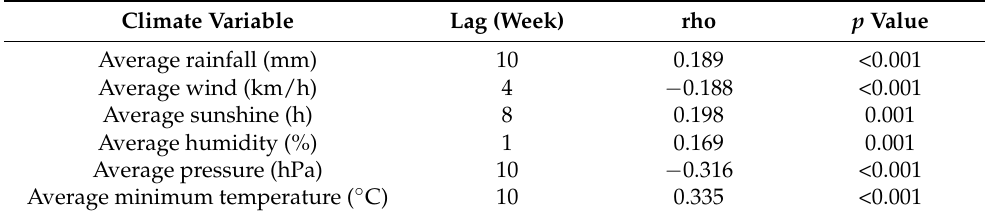
Table 3. Summary of the cross-correlation analysis, Asuncion,